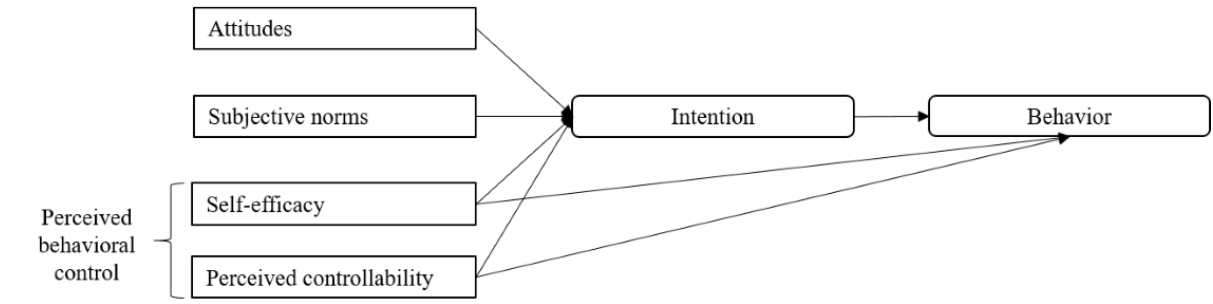
Figure 1. Conceptual model of the theory of planned behavior (adapted from Ajzen